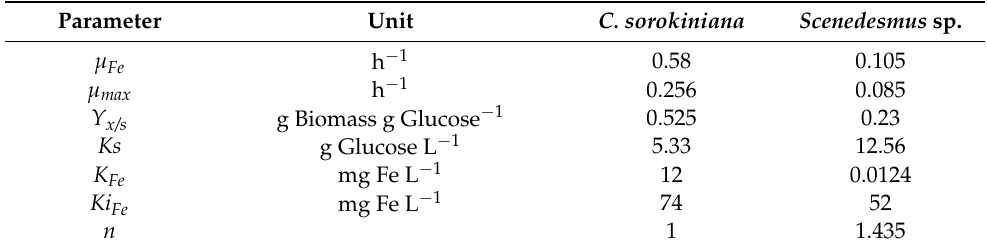
Table 2. Kinetic model parameters optimized from experimental data of iron supplementation effect during the late exponential phase of C. sorokiniana and iron-supplemented cultures of Scenedesmus sp. with reported data obtained from Ren et al.